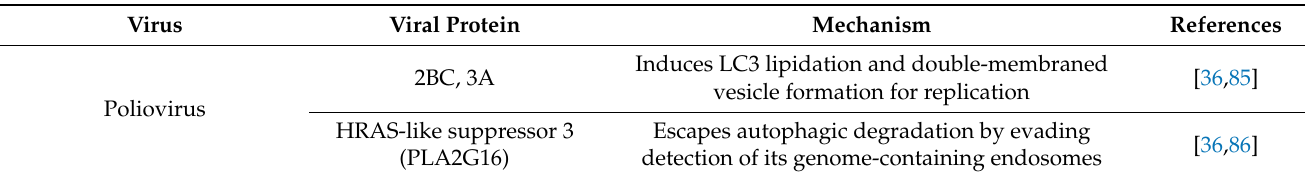
Table 3. Viral antagonism to